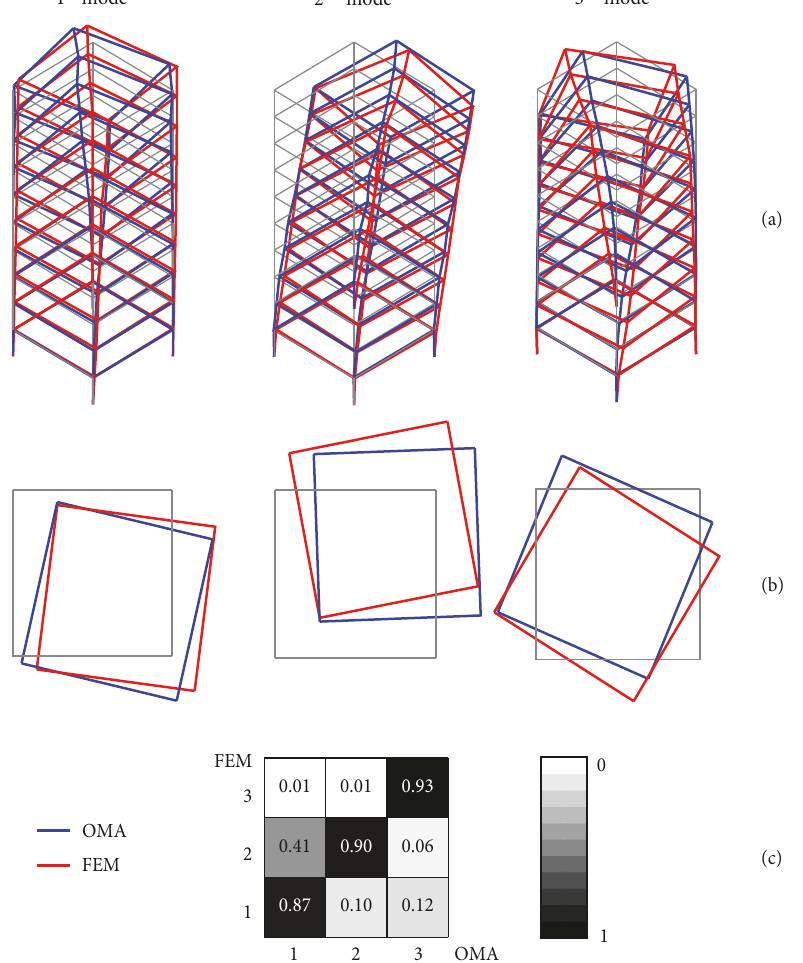
Figure 6: Comparison of experimental and numerical mode shapes: (a) axonometric view; (b) plan view of the last floor; (c)